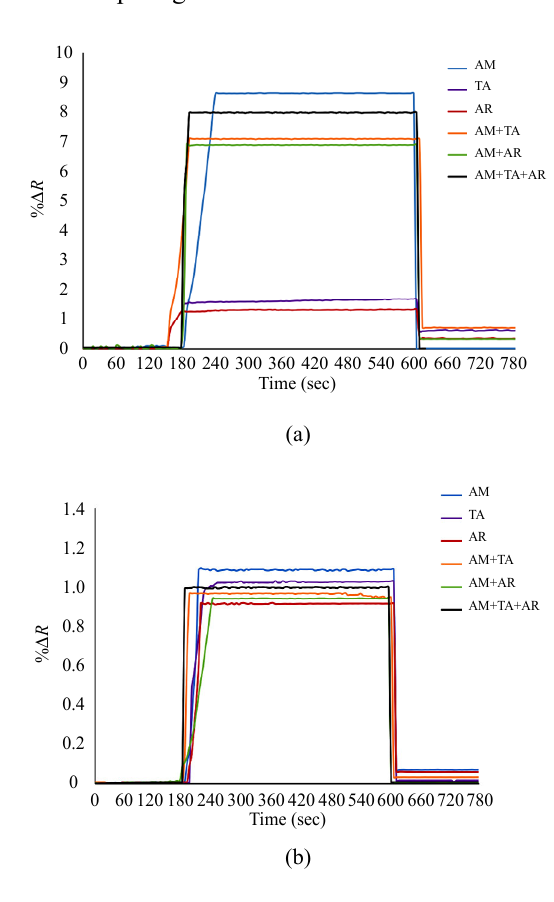
Fig. 8 Selectivity studies: (a) MIP and (b) NIP SPR